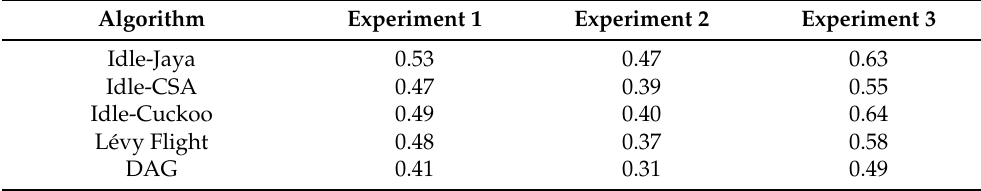
Table 3. The Gini Index average of the simulated representation of FP distribution